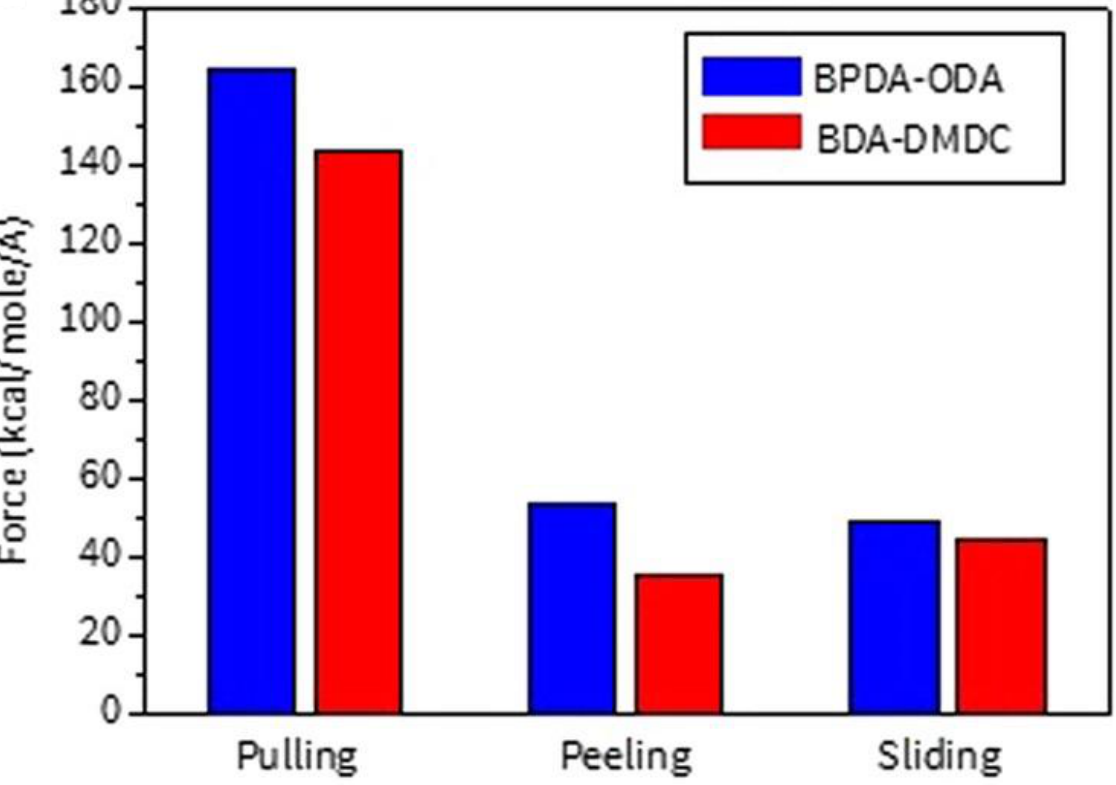
Figure 8. Comparison of adhesion for polyimides between pulling, peeling, and sliding modes of adhesion test (adapted with permission from Reference [27], Copyright 2017 Springer Nature).